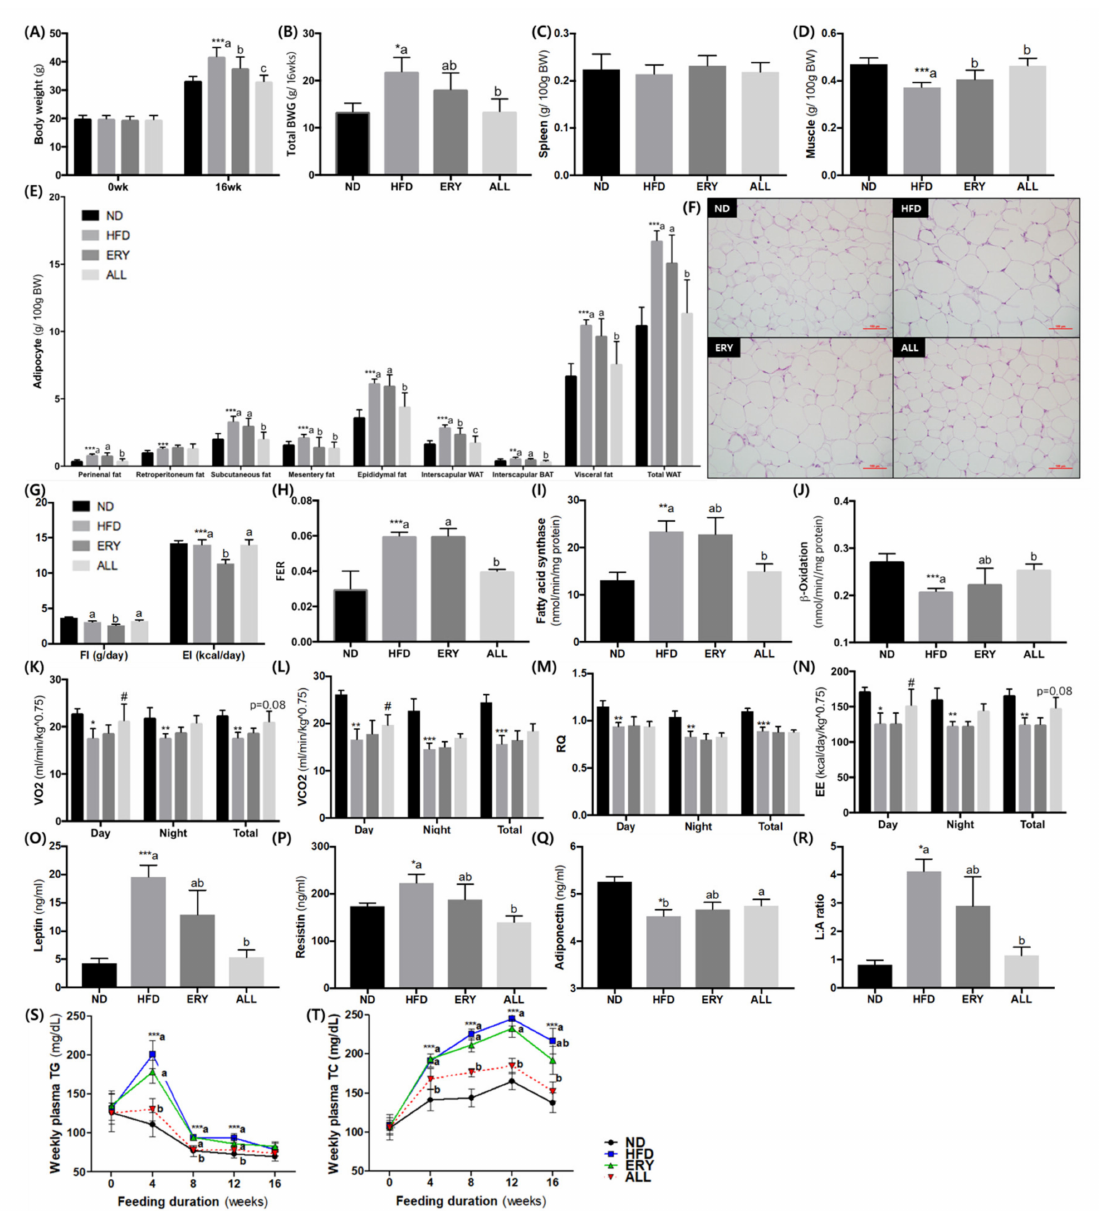
Figure 1. E ff ects of D-allulose supplementation for 16 weeks on; ( A ) Body weight; ( B ) Body weight gain; ( C , D ) Spleen weight and muscle weight; ( E , F ) Adipocyte weight and morphology; ( G ) Food intake and energy intake; ( H ) Food e ffi ciency ratio; ( I , J ) Adipocyte enzyme activity-related lipid metabolism; ( K – N ) Metabolic rate, ( O – R ) adipokine levels and weekly plasma ( S ) TG and ( T ) TC. Data are mean ± SE; ND, normal diet (AIN-76); HFD, high-fat diet (AIN-76, 20% fat, 1% cholesterol); ALL, (HFD + 5% D-allulose). Mean values are significantly di ff erent for ND vs HFD, *** p < 0.001; Mean values are significantly di ff erent for HFD vs ALL, ## p < 0.01, ### p < 0.001. (B) BWG, body weight gain; (C) FI, food intake; EI, energy intake; (D) FER, food e ffi ciency ratio = body weight gain / food intake; (E) WAT, white adipose tissue; BAT, brown adipose tissue; (F) hematoxylin and eosin (H&E)-stained transverse section of epididymal fat and liver; Representative photomicrographs of the liver are shown at × 200 magnification; (G) FI, food intake; EI, energy intake; (K) VO 2 , oxygen consumption, (L), VCO 2 , carbon dioxide production, (M) RQ, respiratory quotient, (N)EE, energy expenditure, (R) L:A ratio, Leptin:adiponectin ratio, (S) TG, triglyceride, (T) TC, total